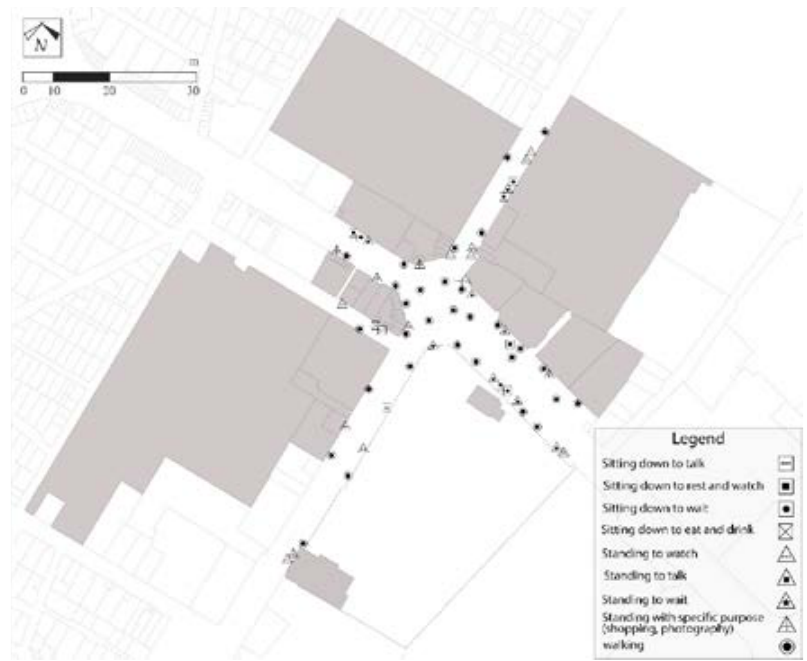
Fig. 6: Locations and types of activities (morning); source: authors